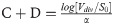
Regulation of division proteins by two proteome sectors quantitatively explain cell size across growth modulations.(A) Hypothesis stating that X expression could depend on the concentration of one or two coarse-grained proteome sectors. Here we assume that Xdiv is invariant. (B) Empirical relationship between cell size and growth rate for three types of growth rate modulation (nutrient quality, chloramphenicol-mediated translation inhibition and expression of useless protein). Data aggregated from three studies, Basan et al. (2015), Si et al. (2017) and Taheri-Araghi et al. (2015). A scaling factor for size was applied on Si et al. and Taheri-Araghi et al. data to make the nutrient modulation data of the three studies consistent (see Fig C in S1 Text). Different branches for useless expression and chloramphenicol indicate modulations at different nutrient quality. (C) Predicted relationship between cell size and growth rate when X expression depends on both E concentration and the fraction of active ribosomes. (D-F) Log-log plots comparing model predictions with experimental data. The natural log is used. (D) Regulation of X expression by E alone can explain size data for nutrient modulation and useless expression modulation (but not chloramphenicol-mediated translation inhibition, Fig D in S1 Text). (E) Among possible regulations of X by two coarse-grained quantities, regulation by E concentration and the fraction of active ribosomes explains size data for all three types of growth rate modulations (this regulation model was used for (C)). (F) Predicted C+D durations agree with measurements by Si et al. (2017). C+D is predicted by C+D=log[Vdiv/S0]α, where α is the growth rate, Vdiv is the model-predicted size (3C and 3E) and S0 is a constant measured in Si et al. (2017).